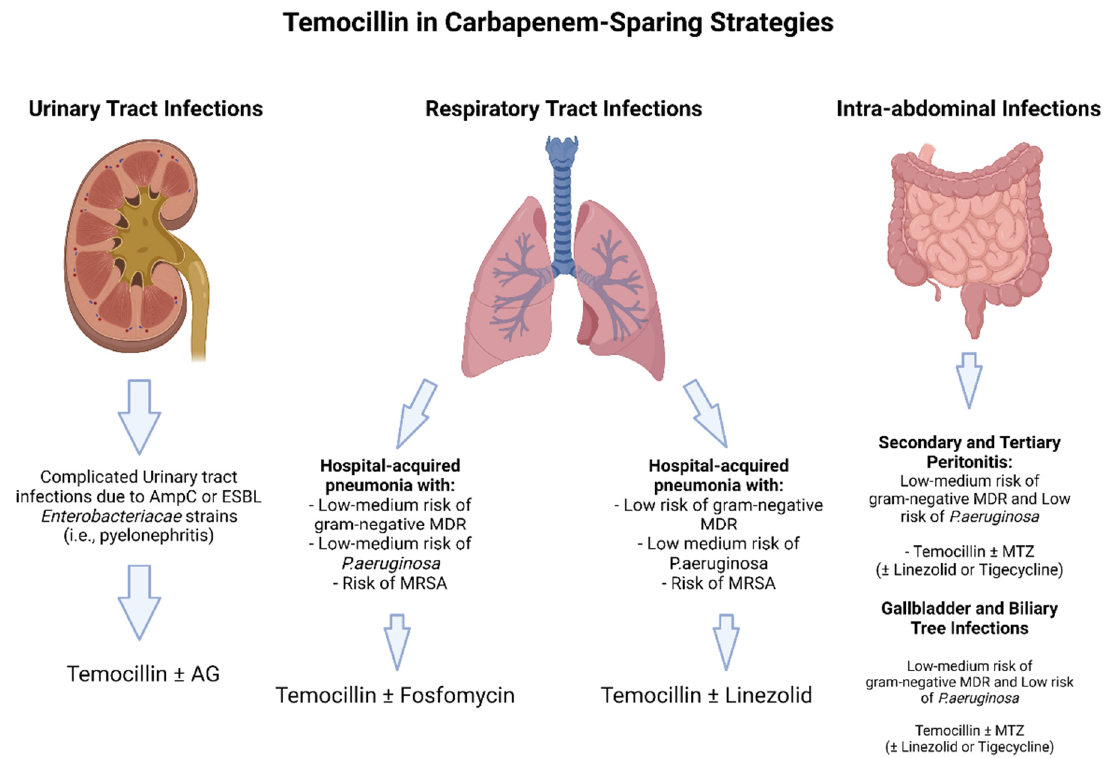
Figure 2. Theoretical carbapenem sparing regimens including Temocillin. Abbreviations: ESBL: extended spectrum Beta-lactamases; AG: aminoglycosides: MDR: multi-drug resistant; MRSA: methicillin resistant Staphylococcus aureus ; MTZ: metronidazole.